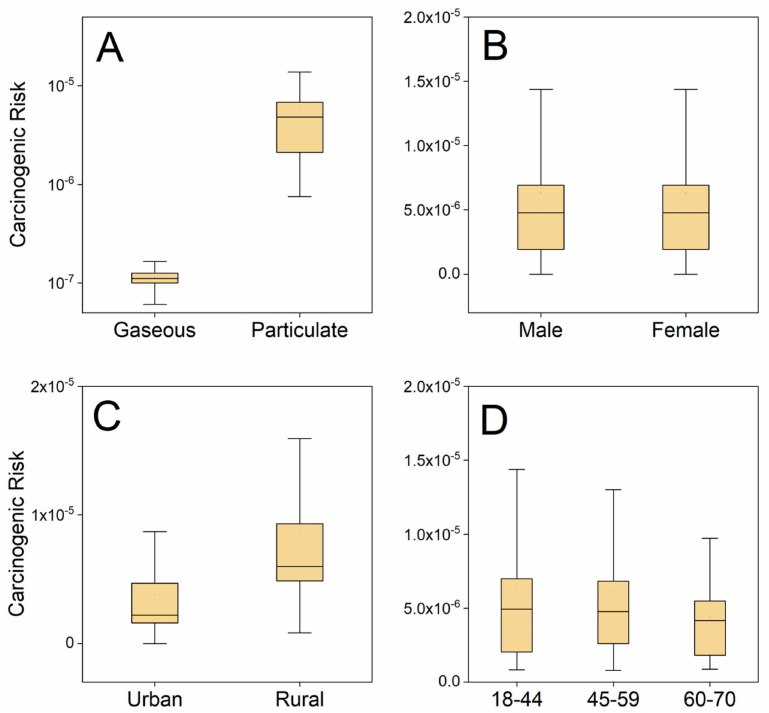
Figure 2. Influencing factors of ILCR of participants from Taiyuan. Difference of risk ( A ) between exposure phrases, ( B ) between genders, ( C ) between urban and rural populations, and ( D ) among age